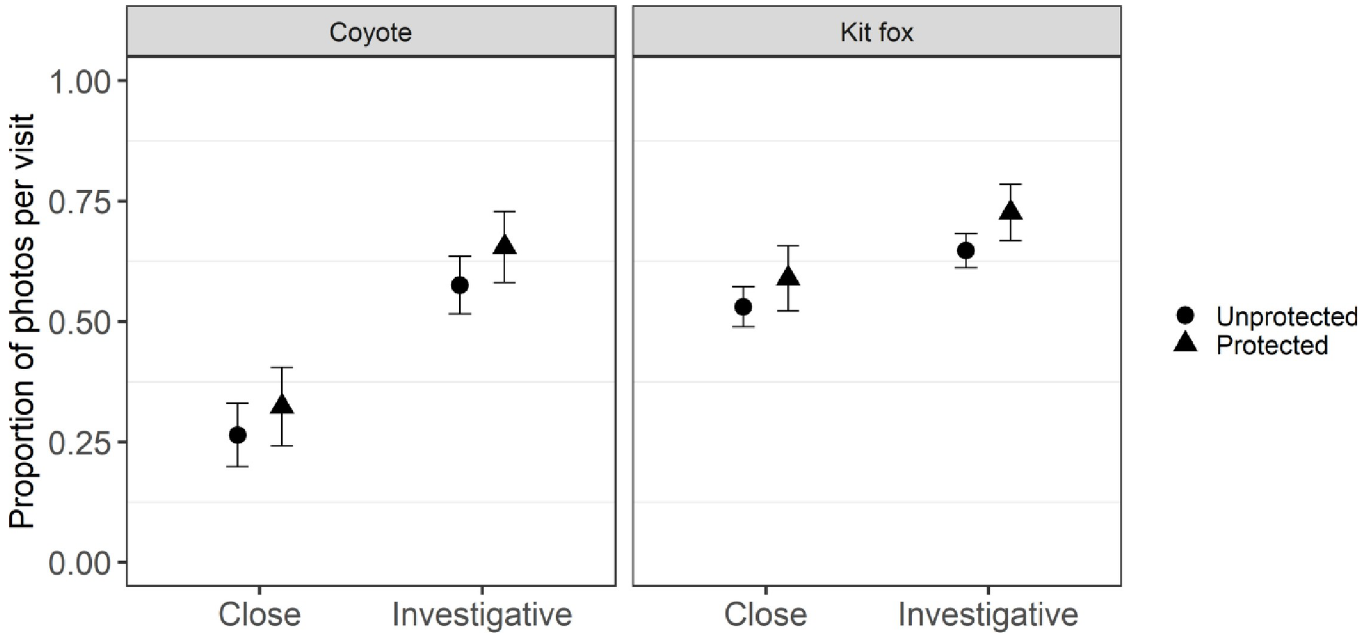
Fig 3. Proportion of investigative and close (within one meter) photographs per visit ( ± 85% CI) by kit fox ( Vulpes macrotis ) and coyote ( Canis latrans ) at scent stations in Utah (2015–2016). Protected sites were on Department of Defense land, where hunting and trapping were not allowed. Unprotected sites were on public land and permitted harvest